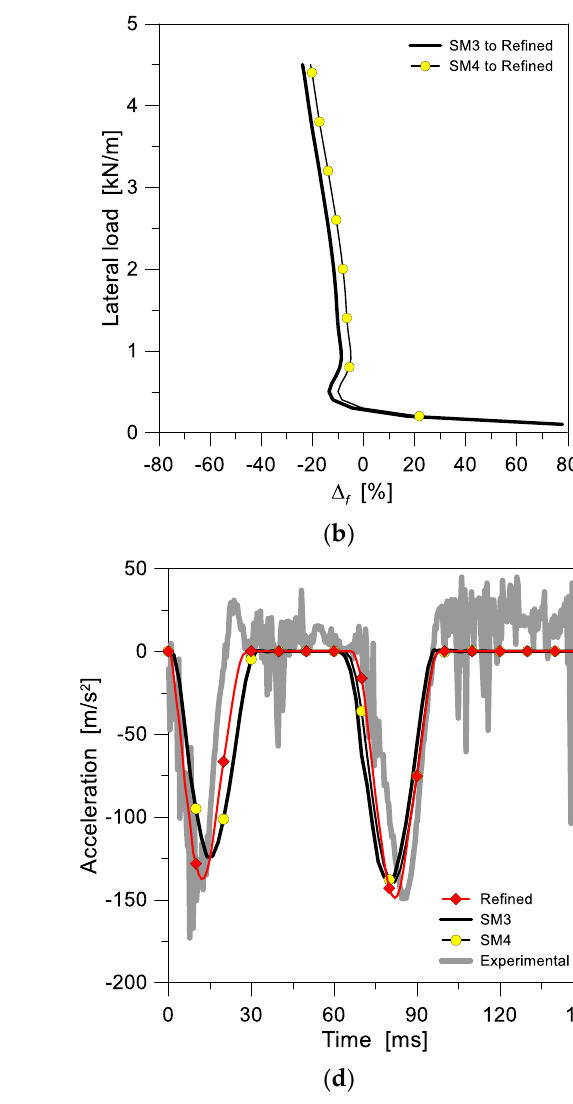
Figure 16. Numerical analysis of the Refined model, SM3 (translational springs) simplified model, and SM4 (rotational springs) simplified model (ABAQUS): ( a ) top lateral displacement under quasi- static load ( P = 4.5 kN/m) at the top edge of glass and ( b ) calculated percentage scatter of SM to Refined models (Equation (32)), with ( c , d ) response analysis under double twin tyre impact (300 mm being the drop height).